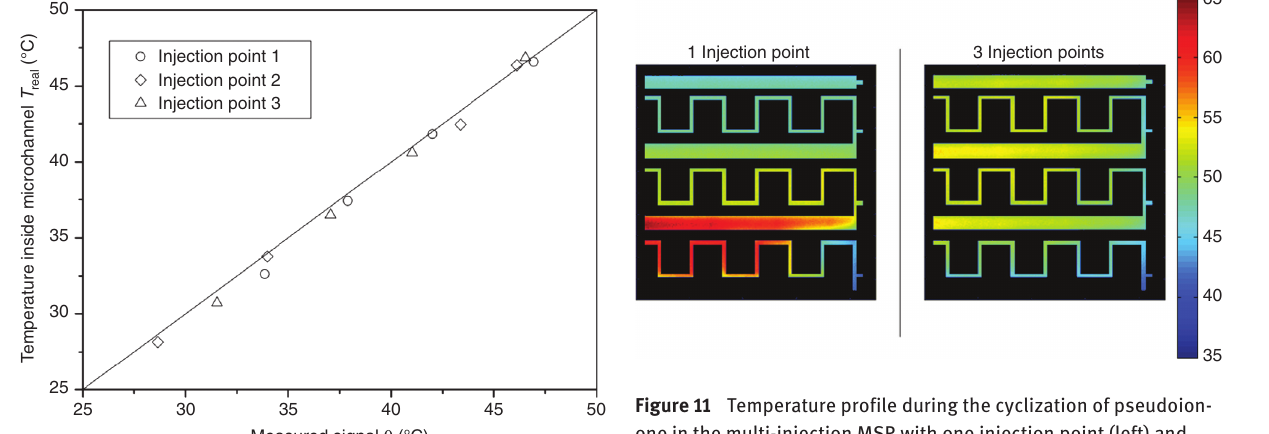
Figure 11 Temperature profile during the cyclization of pseudoion- one in the multi-injection MSR with one injection point (left) and with three injection points (right). Initial concentration of the two = 7.5 m and c = 1.5 m; total flow rate: 3 ml/min inlet solutions: c H 2 SO 4 PI = 48 ° C; T = 48 ° C (0.18 m/s); ∆ T ad c